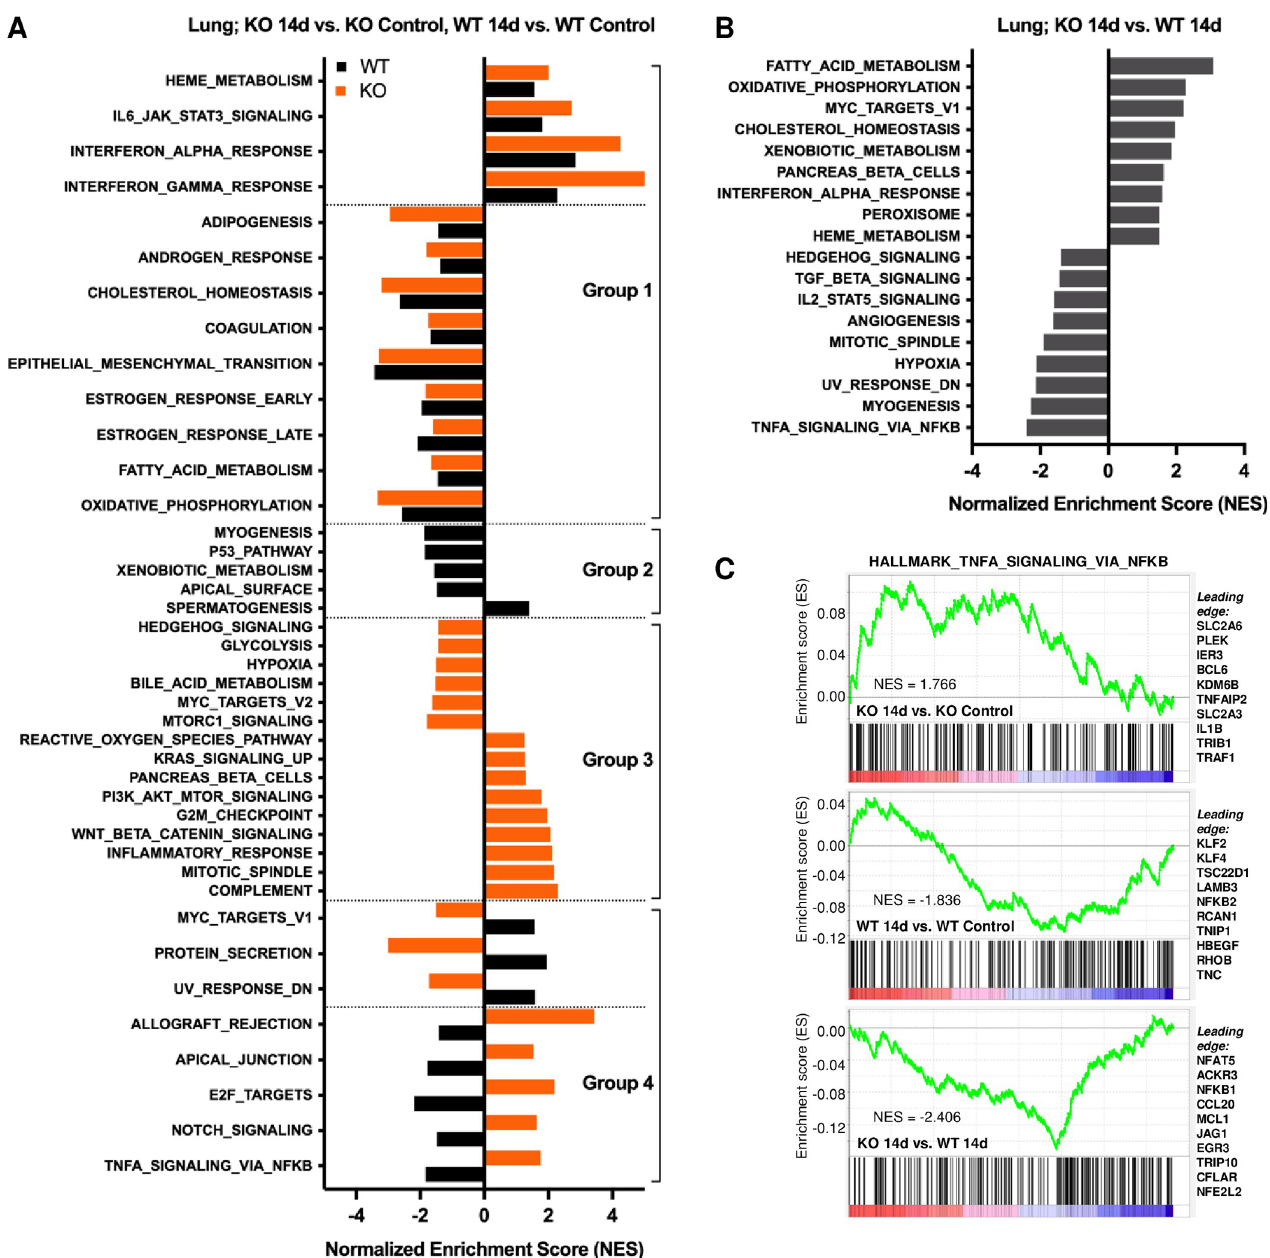
Fig 8. RNA-seq reveals that host genotype determines the consequences of a distant primary tumor on the lung transcriptome. ( A ) Significant (FDR < 0.25) Hallmark pathways identify transcriptomic changes that occur in the lungs of 6DT1 tumor-bearing Clic4 wildtype (WT) or knockout (KO) mice relative to the lungs of genotype-matched healthy control mice 14 days after implantation. Gene set enrichment analysis (GSEA) normalized enrichment scores (NES) are shown. Group 1, similar regulation between WT and KO; Group 2, significant for WT only; Group 3, significant for KO only; Group 4, opposite regulation between WT and KO. ( B ) Gene set enrichment analysis (GSEA) to identify significant enrichment (FDR < 0.25) in Hallmark pathways based on genes differentially expressed in KO vs. WT lungs at 14 days after primary tumor implantation. ( C ) Enrichment plots for the “TNFA signaling via NFKB” Hallmark pathway for the three comparisons shown in panels A and B. The ten most significant leading edge genes are listed to the right of each